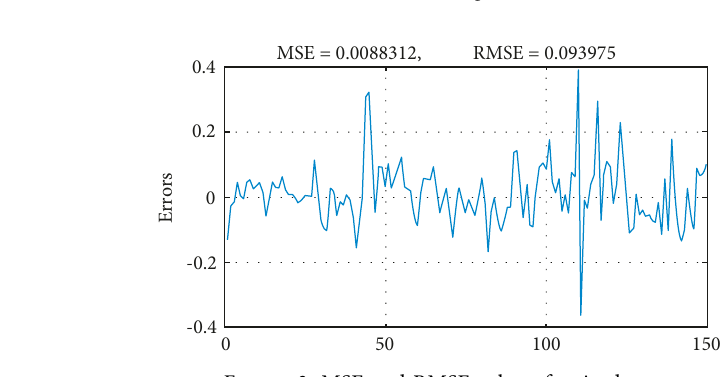
Figure 2: Training data set.